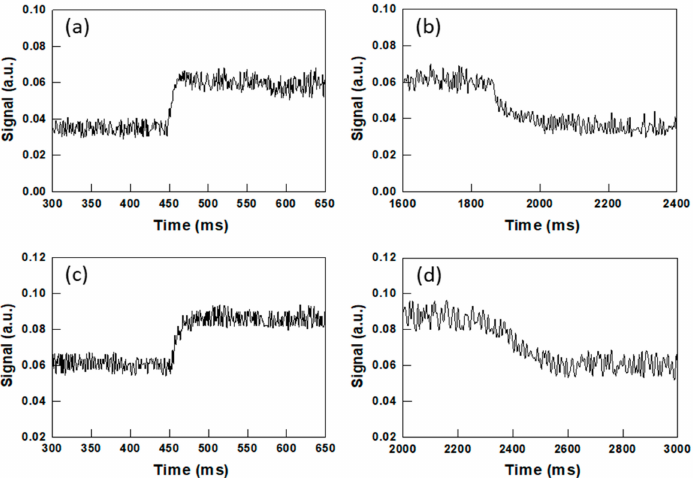
Figure 7. Time evolution of the intensity of the light transmitted by PSCLCs with ( a , b ) 3 ± 0.2 µ m and ( c , d ) 5 ± 0.2 µ m thickness when a DC voltage is switched on and o ff . For the PSCLC with 3 µ m, a 40 V DC voltage is ( a ) applied directly at t ~ 450 and ( b ) removed at t ~ 1850 ms. Rise and fall times are ~30 ms and ~150 ms. For the PSCLC with 5 µ m thickness, 45 V DC are ( c ) applied at t ~ 450 ms and ( d ) removed at t ~ 2300 ms. Rise and fall times are ~50 ms and ~200